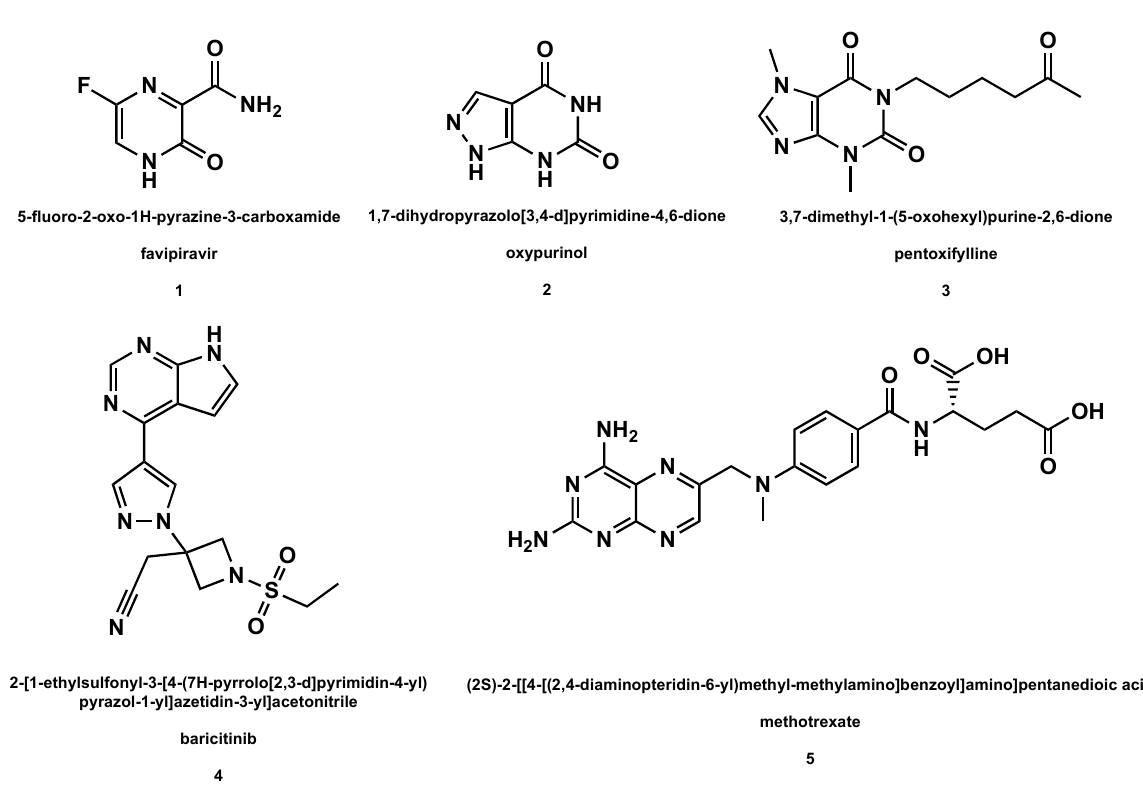
Figure 1. Structures of the nucleoside precursors and derivatives of purine analogs (with drug names and related IUPAC nomenclature) used or under investigation in the HCoV disease therapy.